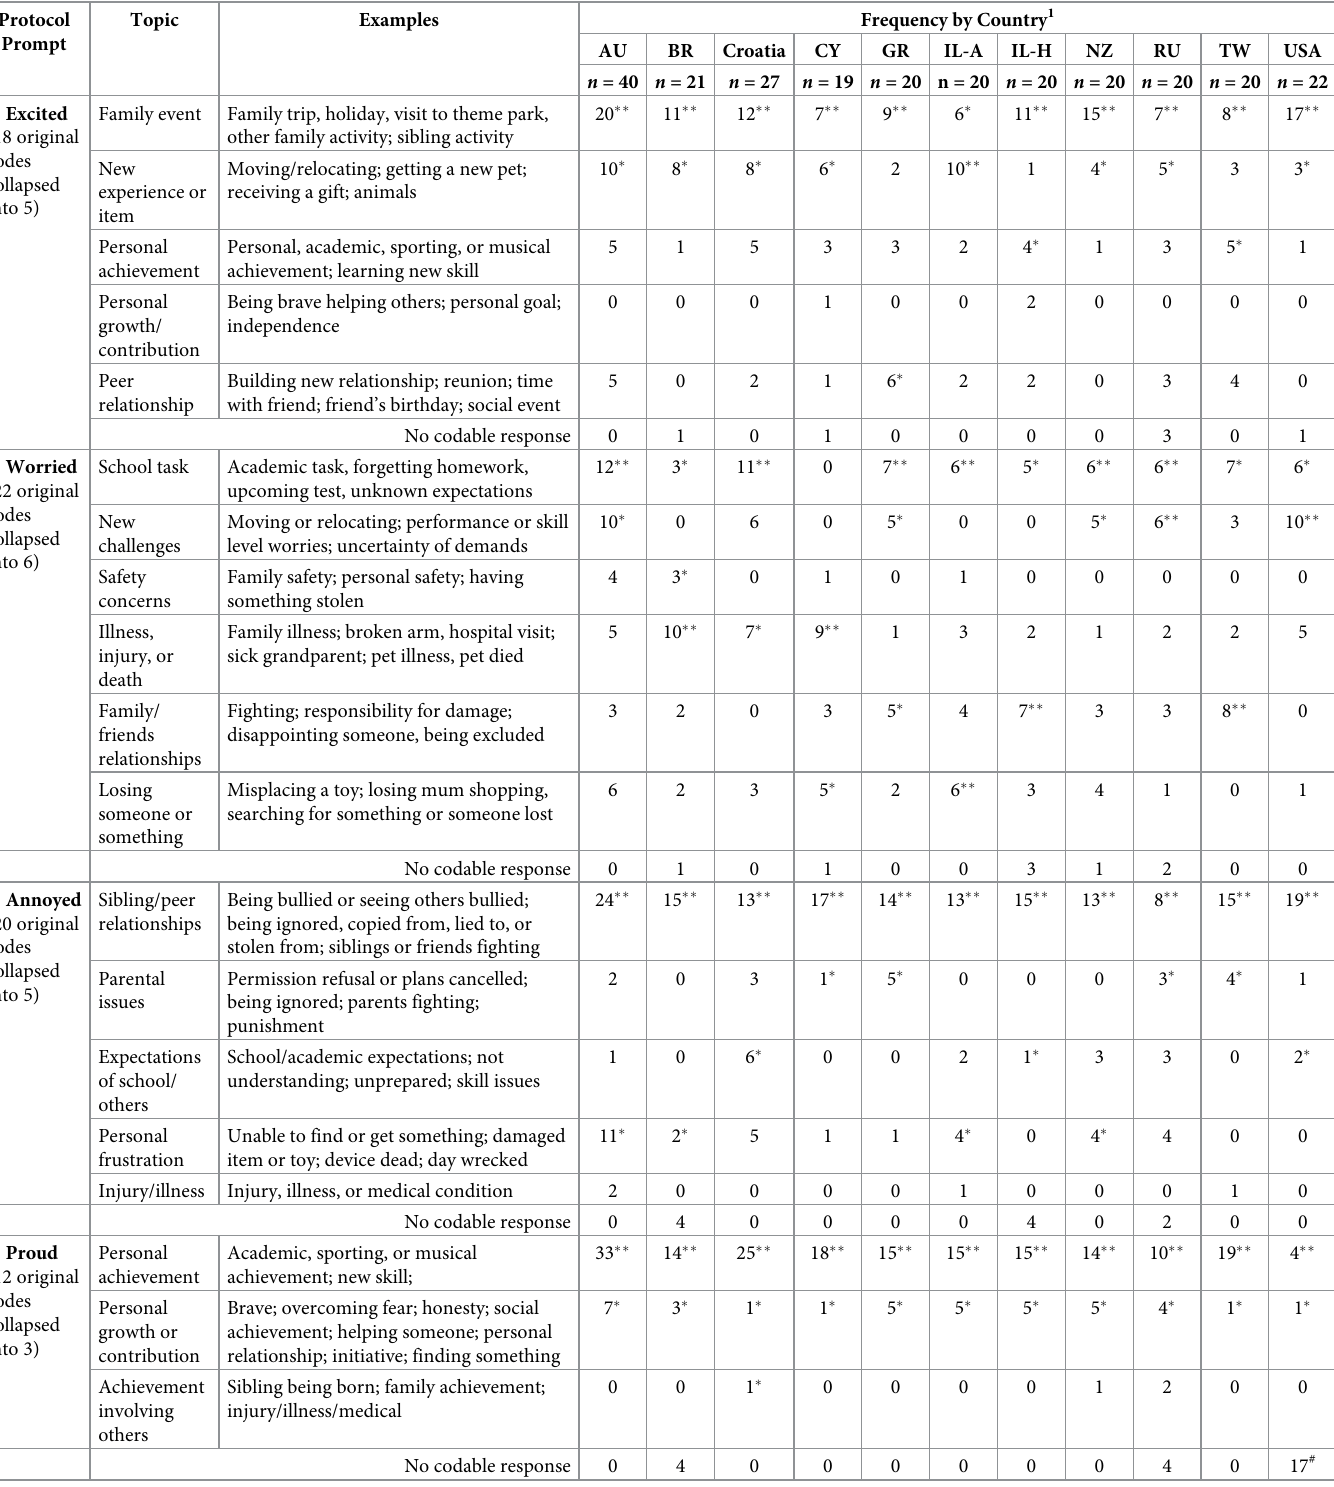
Table 5. Summary of refined topic codes by country for the six protocol prompts, marked to show topics with highest �� and second highest � frequencies. Protocol Prompt